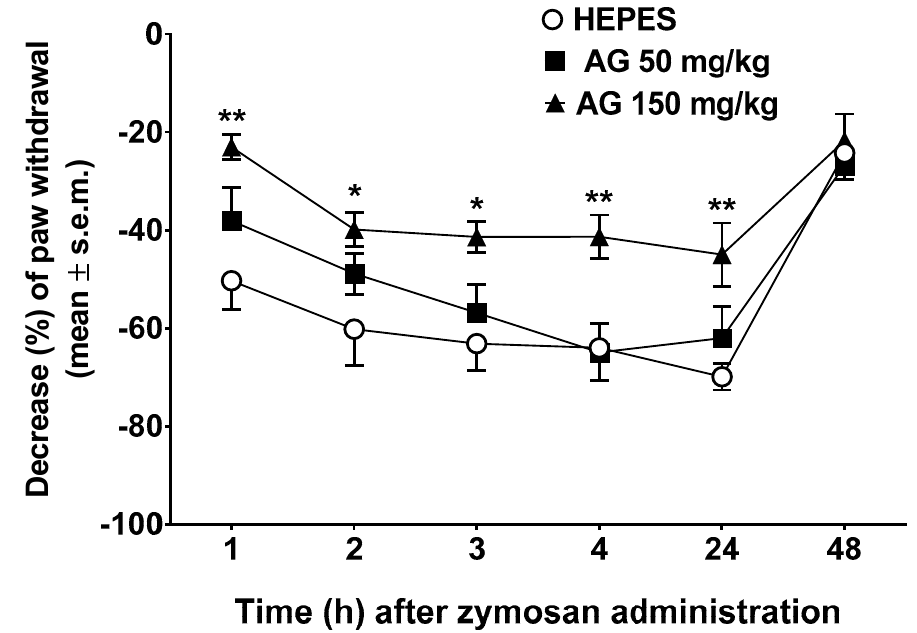
Figure 4. Zymosan-induced hyperalgesia. Effects induced by vehicle (Hepes, 10 mL/kg, intraperitoneally (i.p.)) and ammonium glycyrrhizate (AG, 50 or 150 mg/kg, i.p.) administered 10 min before zymosan (2.5% w/v in saline, 20 µL/paw). * denotes p < 0.05 and ** denotes p < 0.01 vs. Vehicle. n = 10.